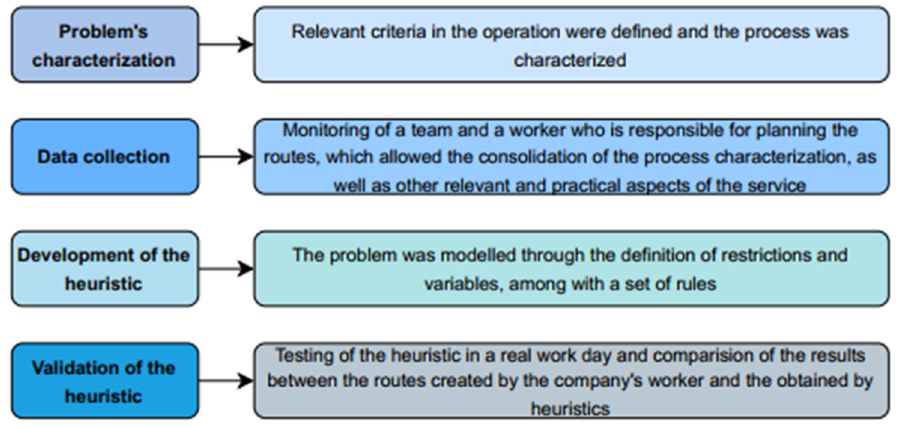
Figure 1. Research